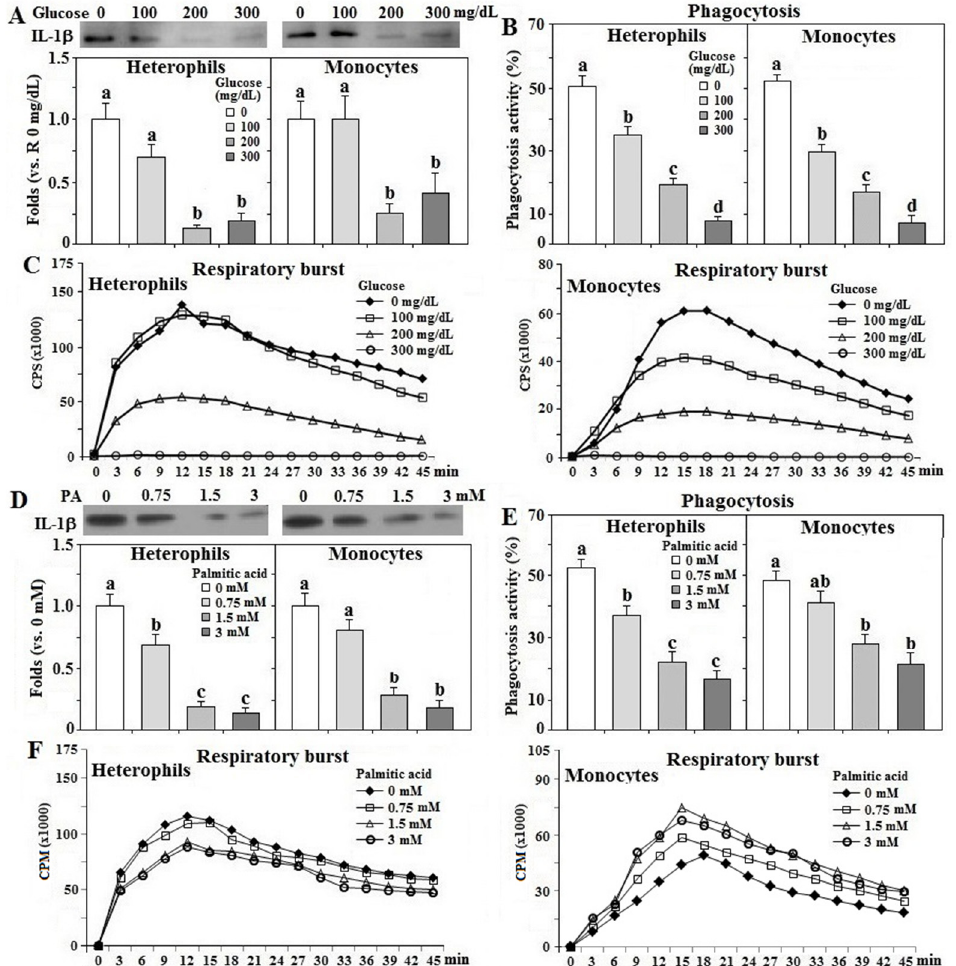
Figure 6. Effects of glucose and palmitic acid on leukocyte functions. Peripheral heterophils and monocytes (2 × 10 6 cells) isolated from R-hens at age 61–65 weeks were treated with various levels of glucose or palmitic acid (PA) overnight (16 h). Media were collected for interleukin-1 β (IL-1 β ) analysis by Western blot method based on equivalent amounts of protein ( A , D ) and collected cells were used for phagocytosis analysis ( B , E ) and respiratory burst analysis ( C , F ) ( n = 4). Chemiluminescence results of respiratory burst analysis were expressed as count per second (CPM) over 45 min. Results of Western blots were expressed as rations relative to control (no glucose or PA supplementation). Means with different letters differ significantly ( p < 0.05).